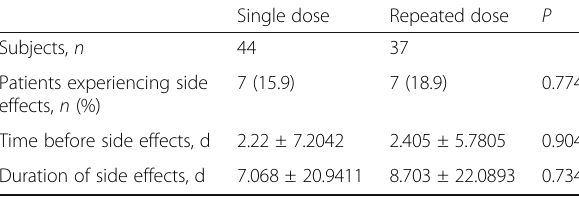
Table 5 Adverse reactions associated with BTX-A treatment Single dose Repeated dose